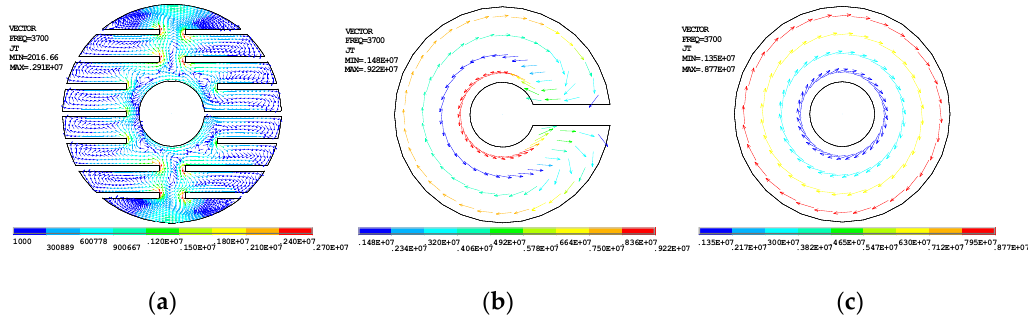
Figure 9. The eddy current distribution for three different rod shapes. ( a ) Rod with digital slots; ( b ) rod with a single slot; ( c ) rod with a hole.